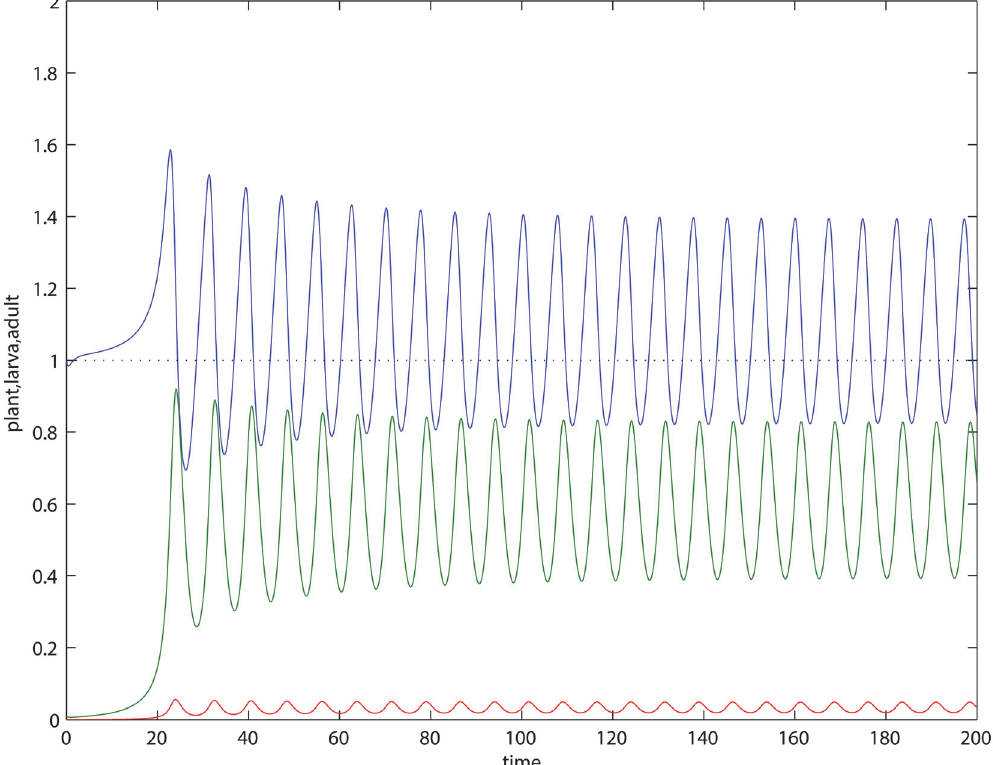
Fig 3. Limit cycles in the PLA model (3). Plant biomass alternates above and below the carrying capacity (dotted line). Parameters as in Table 1, with γ = 0.01, β = 10. Blue:plant, green:larva,